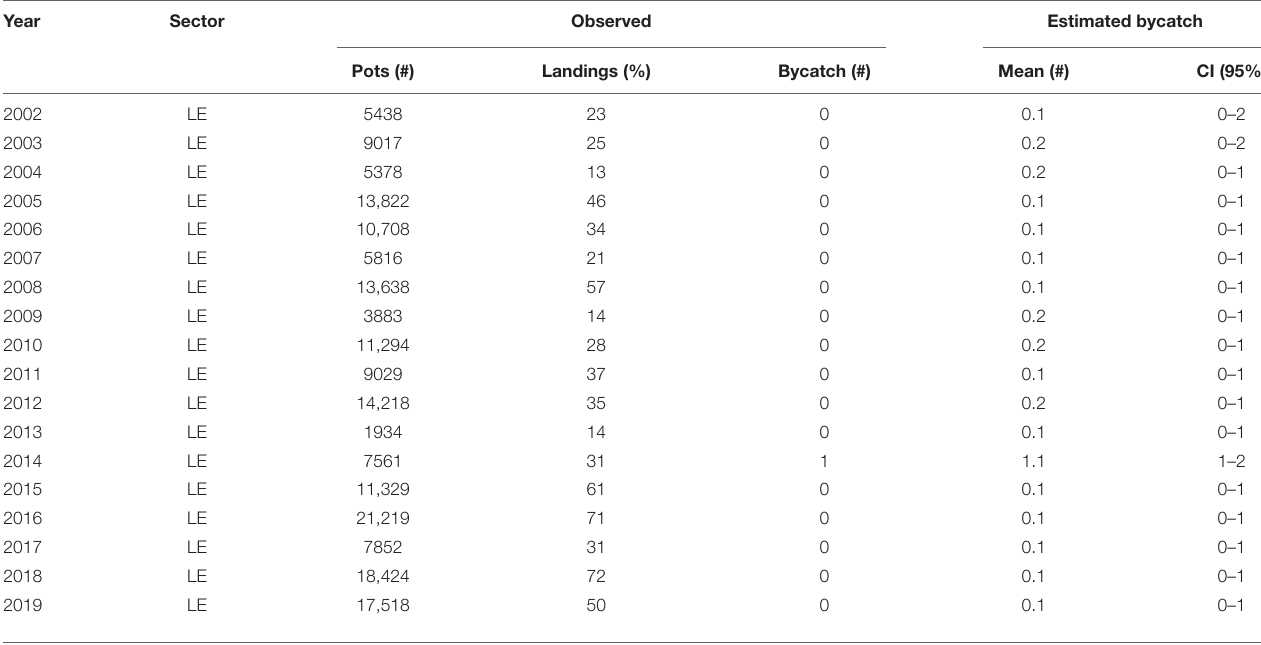
TABLE 2 | The data used to calculate humpback whale bycatch in the LE sablefish pot fishery collected by fishery observers (observed) and the estimated mean and 95% credible interval (CI: lower–upper) from the best model. The best model included a constant bycatch rate, a Poisson count process, and used the number of observed pots deployed as fishing effort.